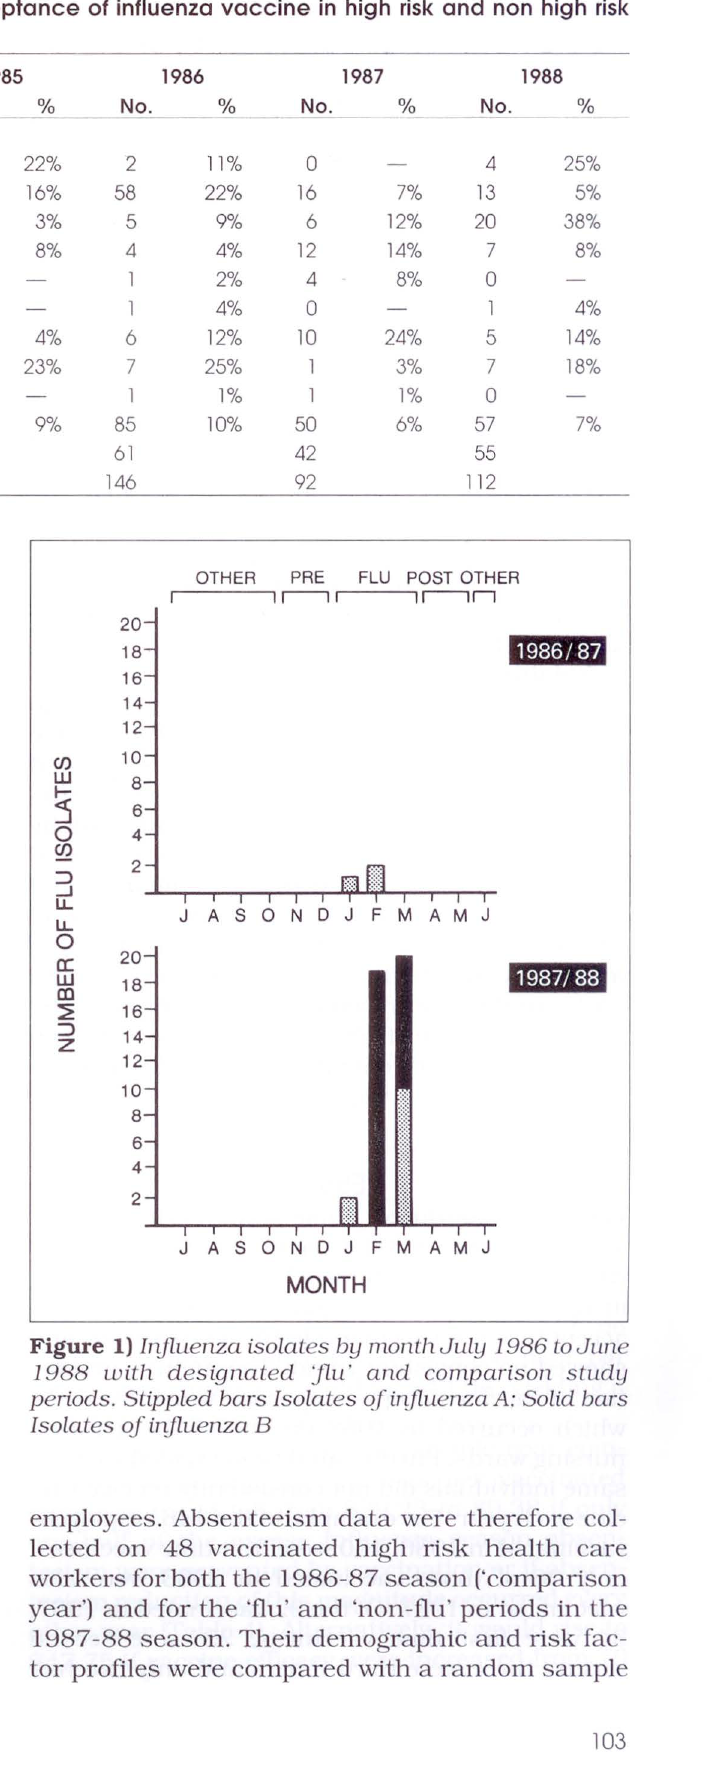
Figure 1) Influenza isolates by month July 1986 to J une 1988 with d es ignated flu· and comparison study periods. Stippled bars Isolates of irifluenza A: Solid bars Isolates of influenza B